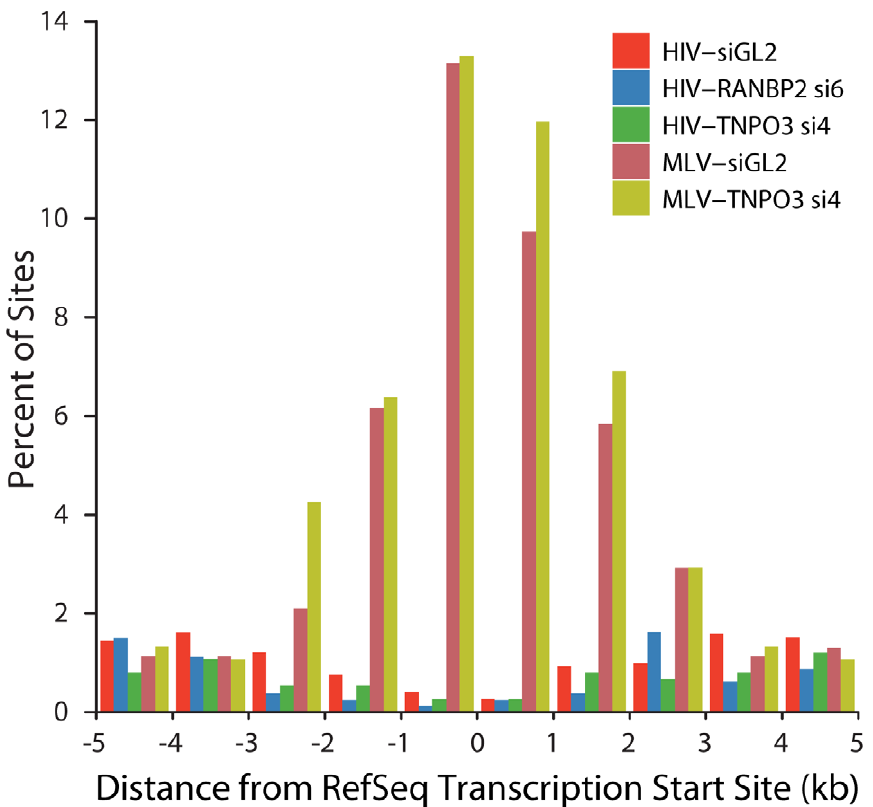
Figure 8. HIV and MLV integration patterns at transcription start sites are unaffected by knockdown of TNPO3 or RANBP2. The percent of integration sites within the indicated genomic distances (kb) from the transcription start site (RefSeq genes) is plotted for each dataset. Sample names indicate the VSVG-pseudotyped viral vector used (HIV or MLV) followed by the cell treatment (either control siGL2 or gene-specific siRNA used).